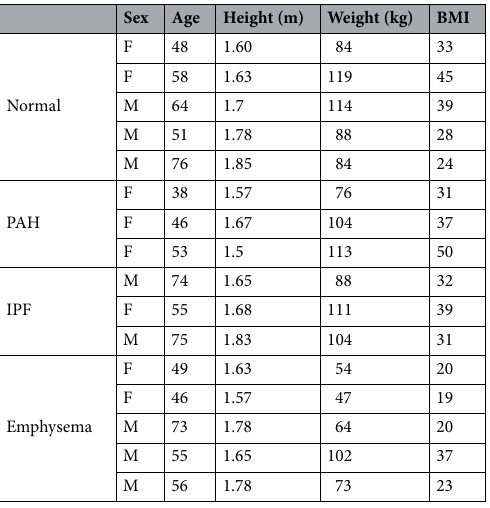
Table 1. Donor demographic data.